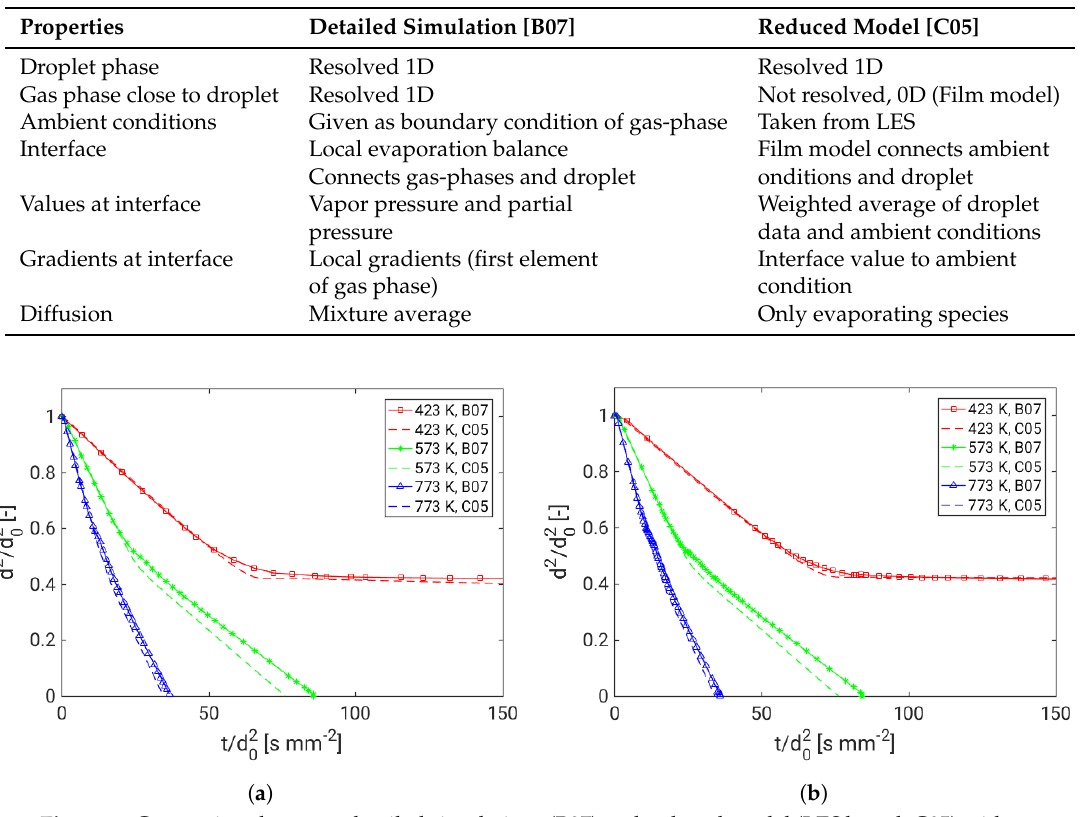
Figure 2. Comparison between detailed simulations (B07) and reduced model (LES based, C05) without chemistry (only evaporation). ( a ) dry air; ( b ) moist